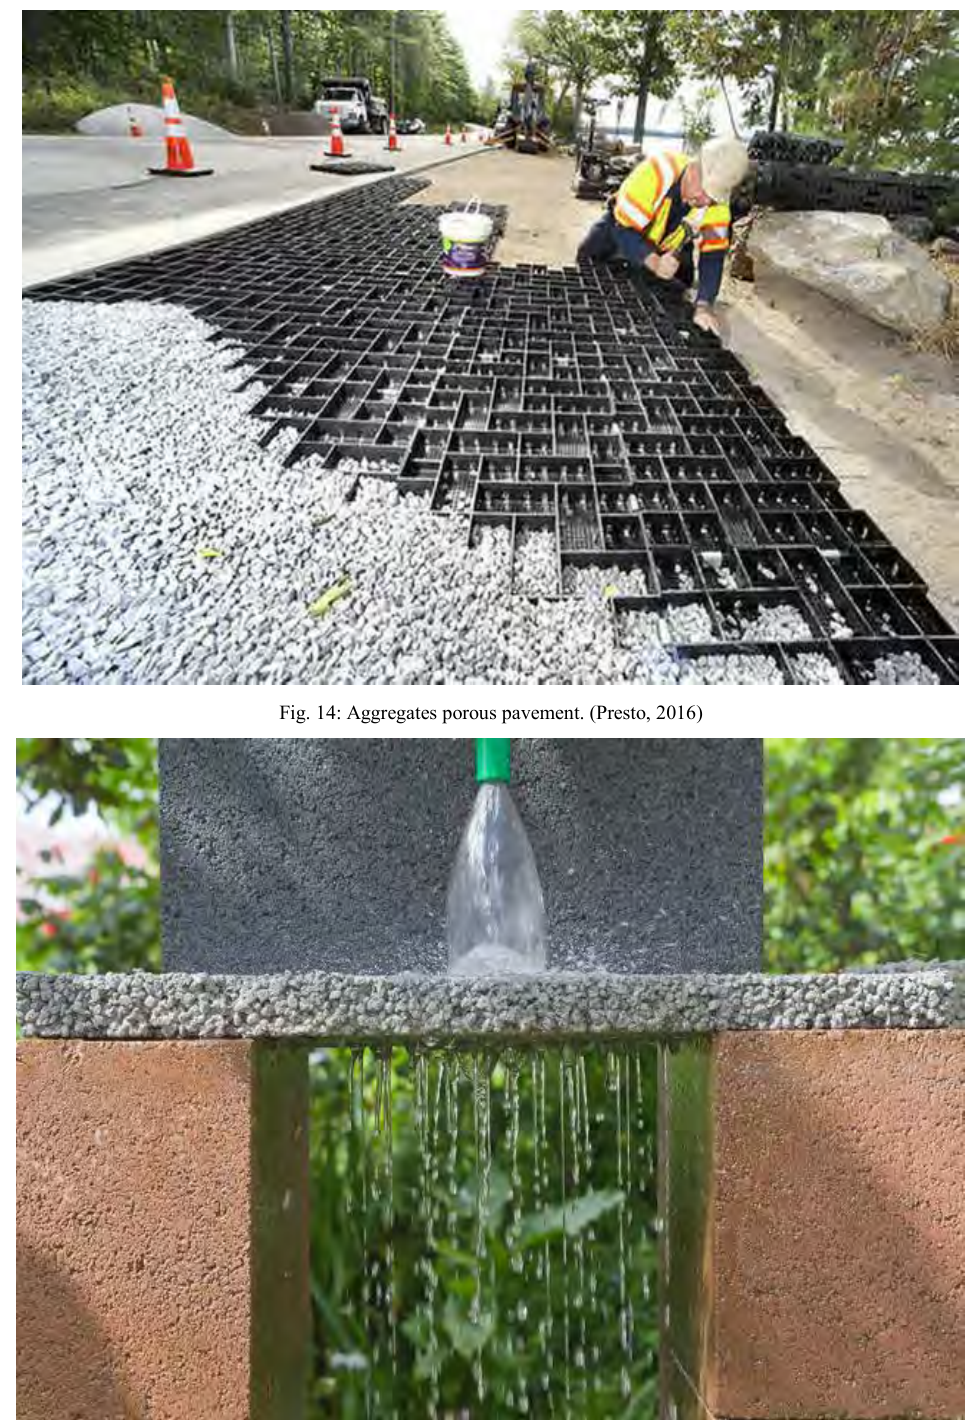
Fig. 15: Permeable